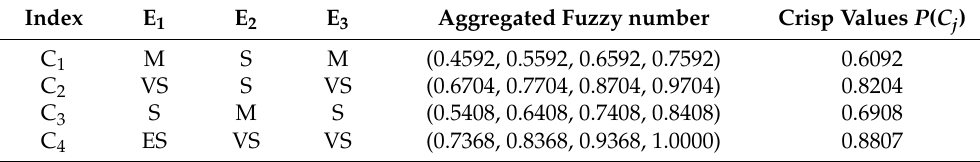
Table 4. The importance of evaluation indicators.